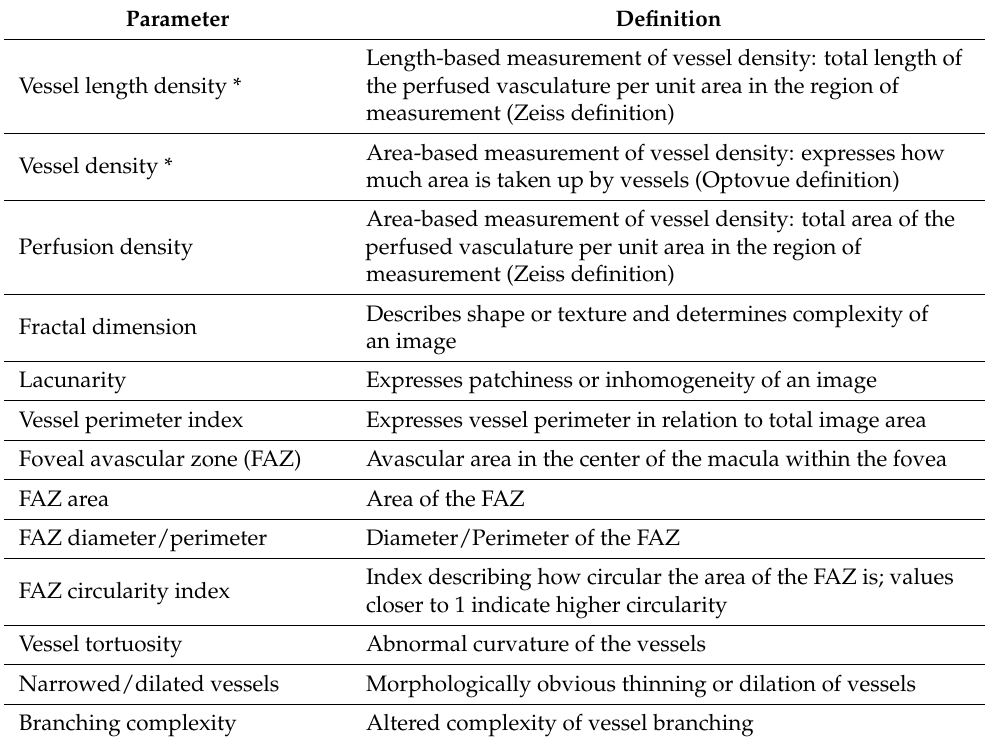
Table 2. Commonly used OCT-A expressions and parameters. * Vessel density can be measured by area- or length-based measurements. Length-based measurements are more sensitive to changes of small capillaries; in area-based measurements, larger vessels have greater influence. Synonyms for vessel density: vascular/microvascular/capillary/flow